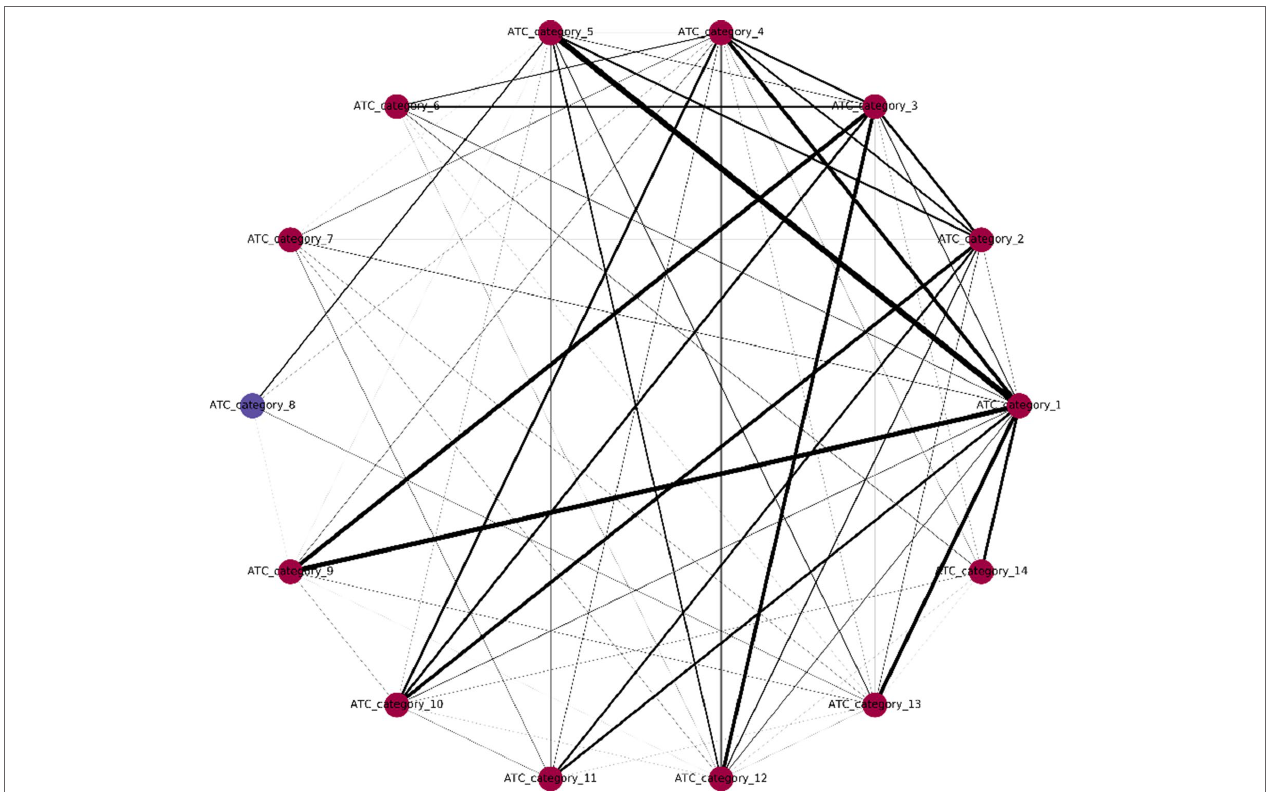
FIGURE 2 | Label relation graph. Different colors stand for different communities. The line width represents the weight between two labels. Communities are detected by multiple async label propagation method, while the weight represents the frequency of label co-occurrence.